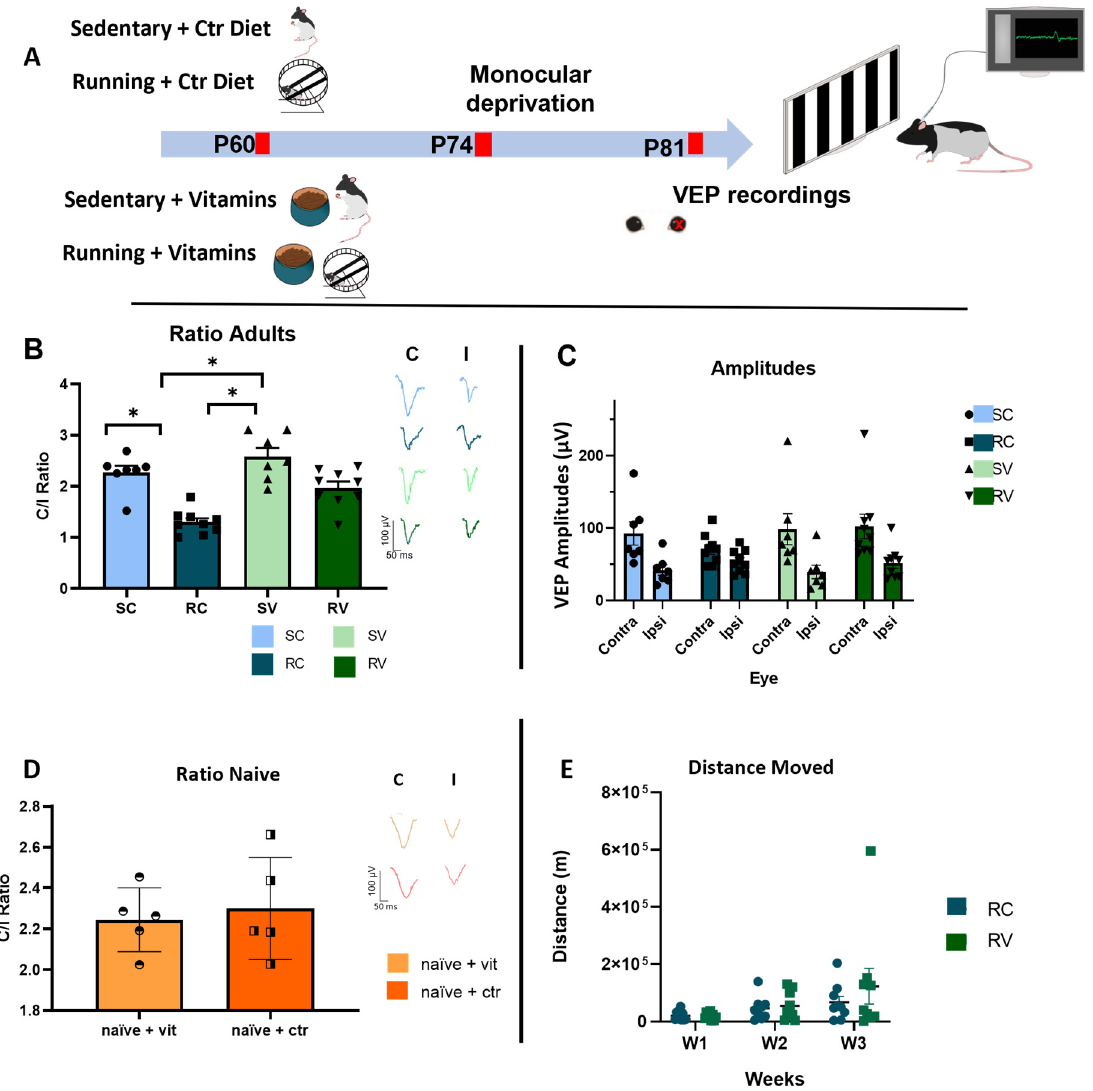
Figure 1. Antioxidant supplementation dampens running-induced visual cortical plasticity in adult rats. ( A ) Schematic diagram of the protocol. ( B ) Ocular dominance (OD) was determined by measuring the controlateral to ipsilateral (C/I) ratio in the amplitude of VEPs. In adult animals, running induced a marked OD shift in rats fed with the control diet (RC rats, n = 9) in response to MD, with a C/I VEP ratio of 1.30 ± 0.08. The C/I VEP ratio in RC rats was significantly lower than that of sedentary rats fed with the standard diet (SC rats, n = 7, C/I VEP ratio = 2.27 ± 0.13,)